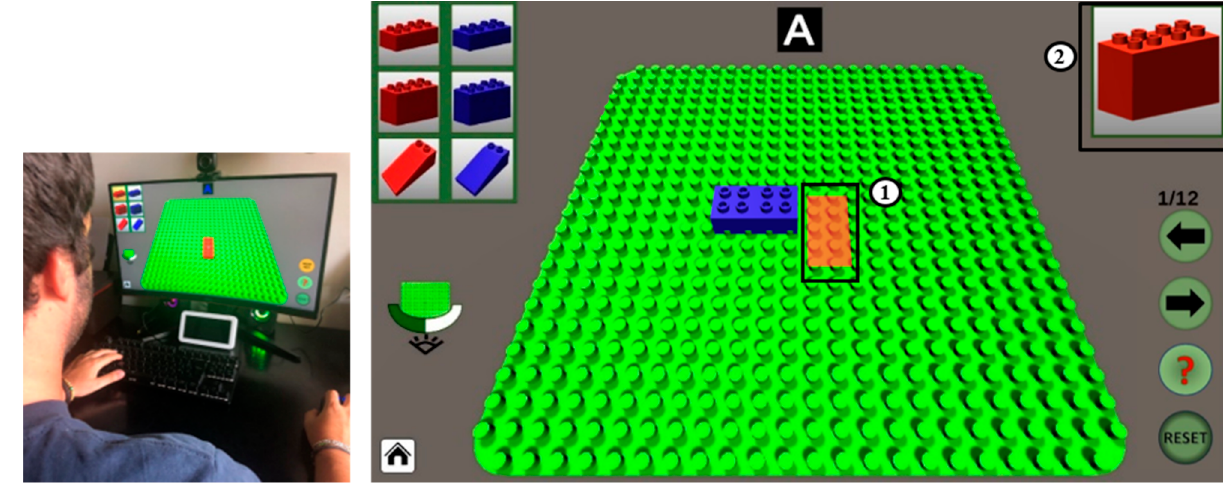
Figure 2. A user while carrying out the experiment with our DSTE at home ( left ); interface of the proposed DSTE ( right ): simulated AR instruction is provided through an auxiliary model used as a world-fixed visual asset ① , and a drawing used as a screen-fixed visual asset ② .